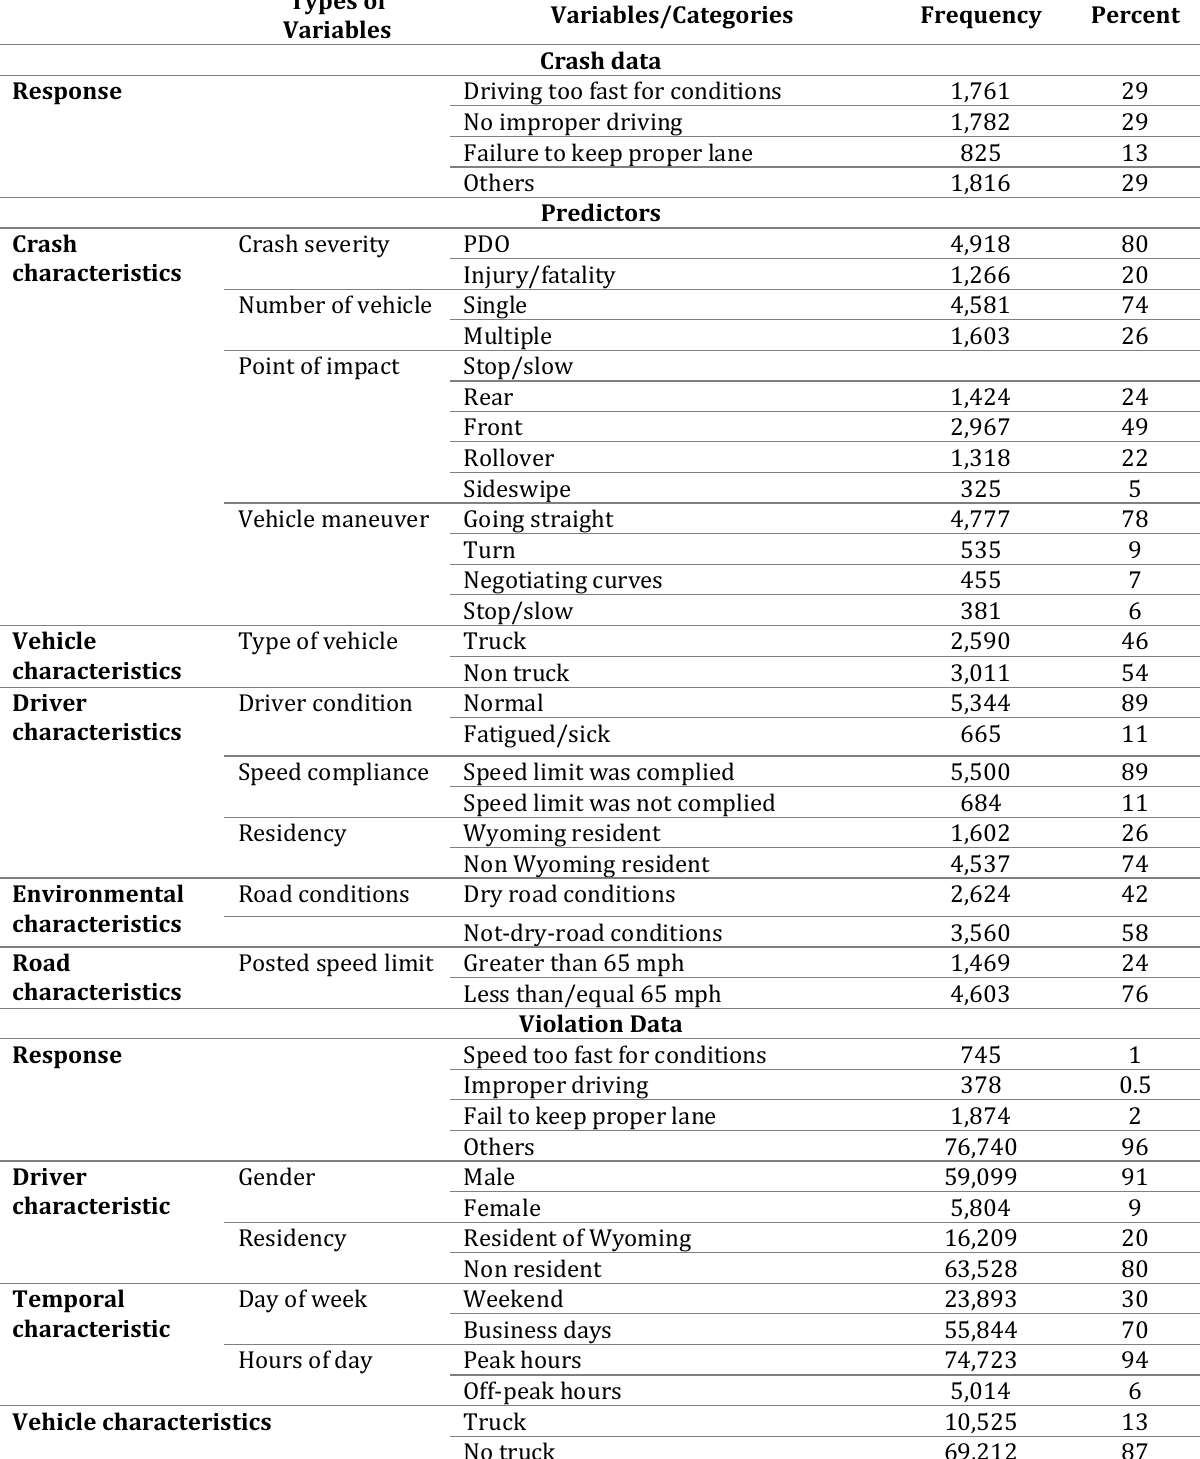
Table 1: Summary of crash